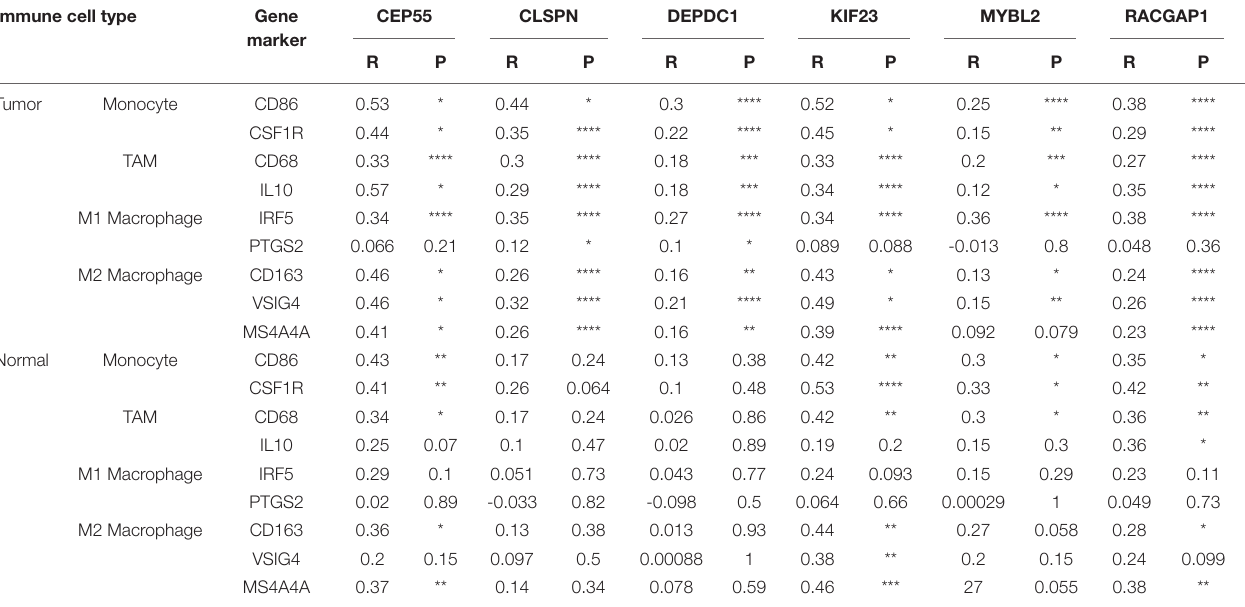
TABLE 2 | The correlation between six hub genes and gene markers of monocyte and macrophages in HCC from GEPIA. Immune cell type Gene CEP55 CLSPN marker